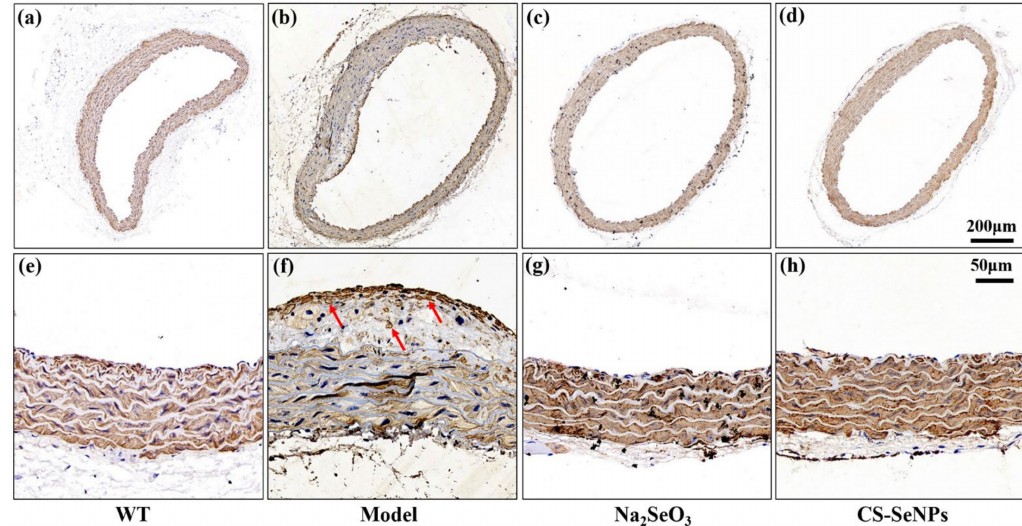
Figure 4. Immunohistochemical staining for α -SMA was performed to characterize the position of VSMCs in aortic root. ( a – d ) Representative images of immunohistochemical staining for α -SMA in aortic root (50 × ). ( e – h ) Magnified views (200 × ) corresponding to ( a – d ). Red arrows refer to brown α -SMA-positive